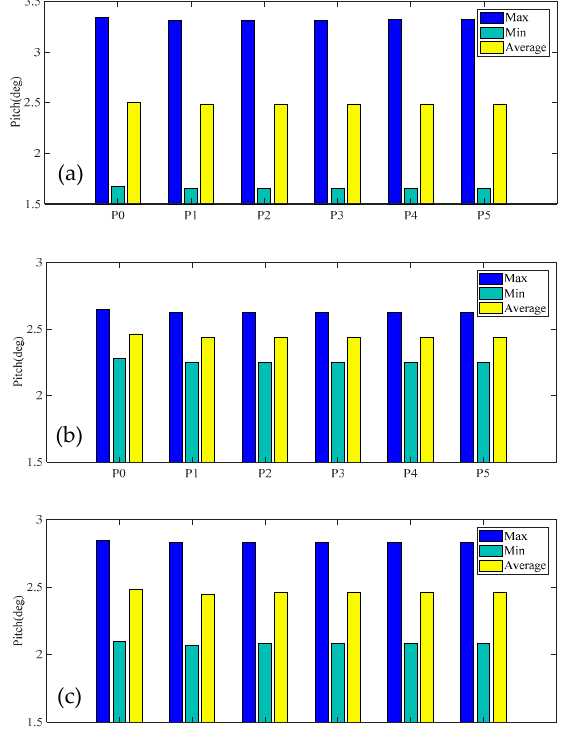
Figure 10. The maximum and minimum values and average values of pitch motion from 600 s to 900 s for ( a ) case 1, ( b ) case 2, and ( c ) case 3.